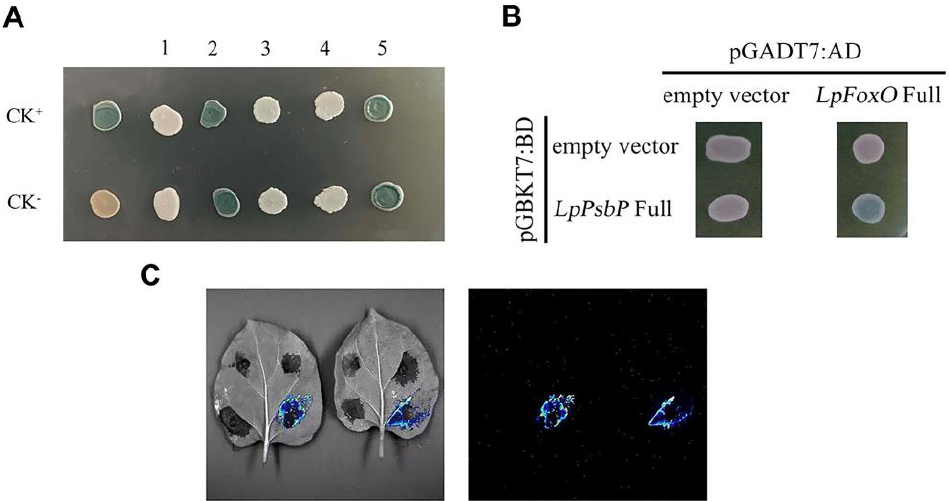
Figure 6. Validation of LpPsbP interacting proteins. ( A ): cDNA library screening of pGBKT7-LpPsbP. Y2H was cotransformed successfully with 5 plasmids related to salt stress and pGBKT7-LpPsbP. When the yeast was grown on SD-Trp-Leu-His plus X-gal media at 30 ◦ C, the transformed yeasts with plasmids 2 and 5 grew as colonies and became blue, while the yeasts with plasmids 1, 3 and 4 did not. ( B ): pGBKT7-LpPsbP and pGADT7-LpFoxO co-conversion validation. On SD-Trp-Leu-His plus X-gal media, the strains cotransformed with pGBKT7-LpPsbP and pGADT7-LpFoxO were able to establish blue colonies, whereas the control group was unable to do that. ( C ): Luciferase complementation assay. The first quadrant: both NLuc and CLuc were unloaded, the second quadrant: NLuc was unloaded, the third quadrant: CLuc was unloaded and the fourth quadrant: pCAMBIA1300-NLuc-PsbP and